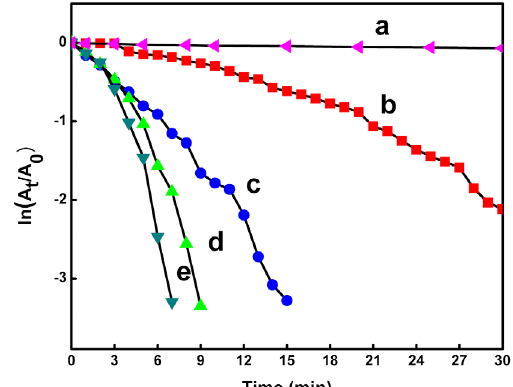
Fig.7. Plot of ln(At/Ao) of reduction of 4-NP catalyzed by PNA